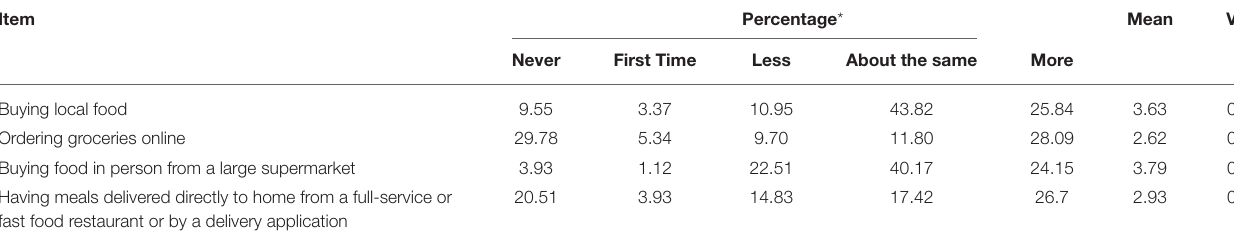
TABLE 2 | Consumers’ behavior trends during the COVID-19 pandemic ( n = 356). Item Percentage * Mean VR ** Never First Time Less About the same More Buying local food